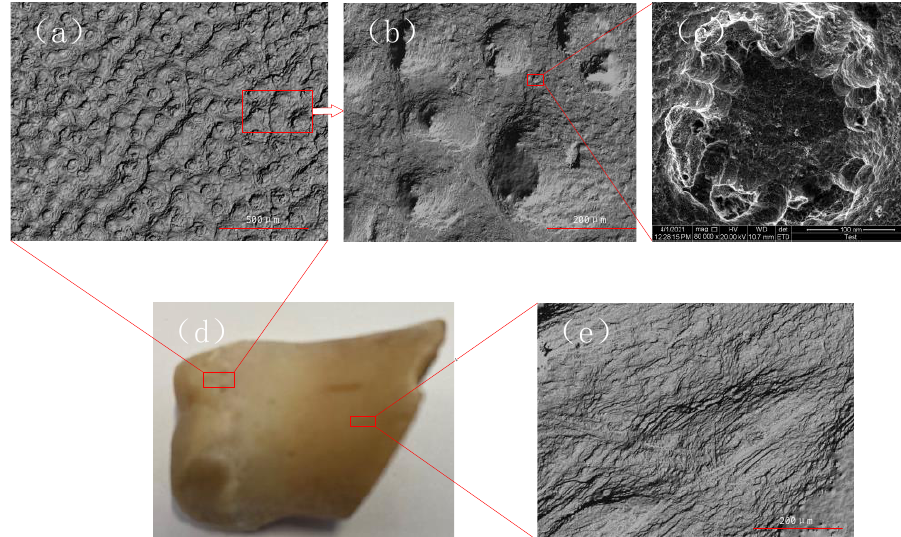
Figure 2. Pork bone surface morphology. ( a ) Surface morphology of pork bones(500 μm ) ( b ) Surface morphology of pork bones(200 μm ) ( c ) Surface morphology of pork bones (100 nm) ( d ) Pork bone sample ( e ) Surface morphology of pork bones (200 μm ).